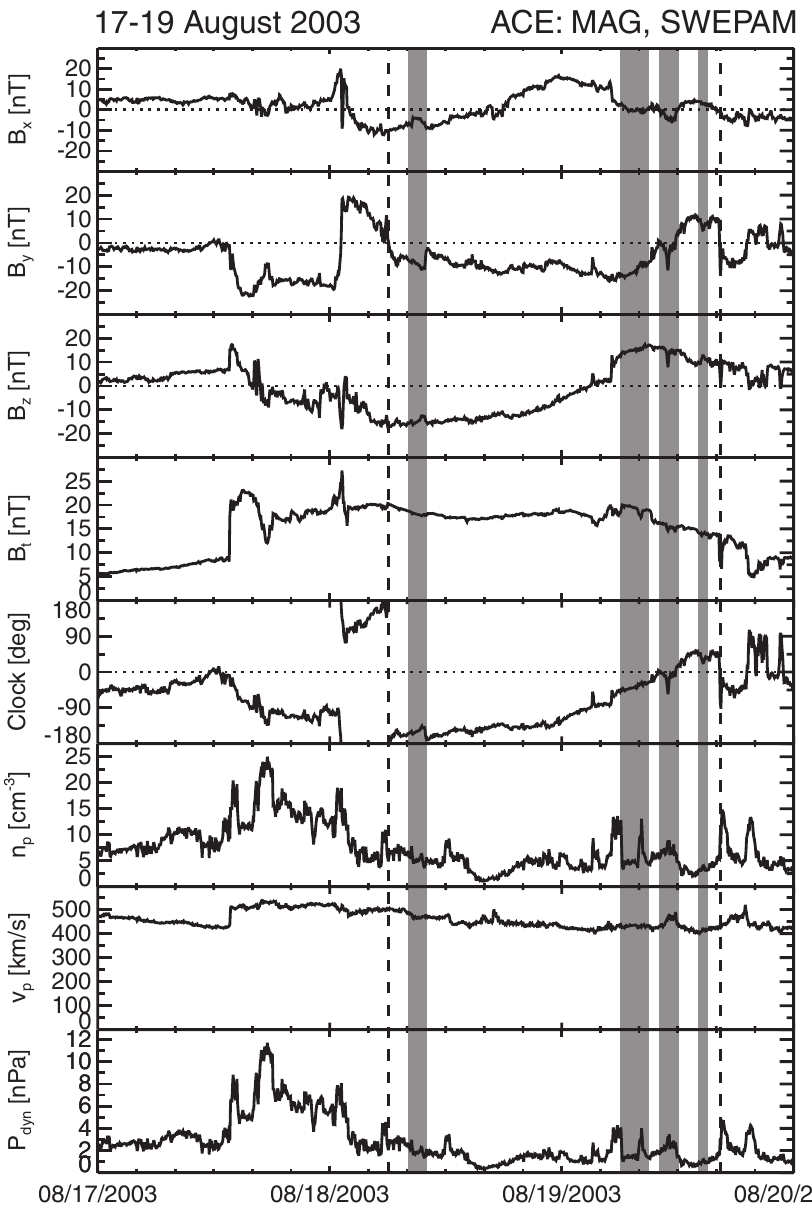
Fig. 1. Solar wind conditions for 17–19 August 2003 as observed by ACE. The interval of the study is marked by vertical dashed